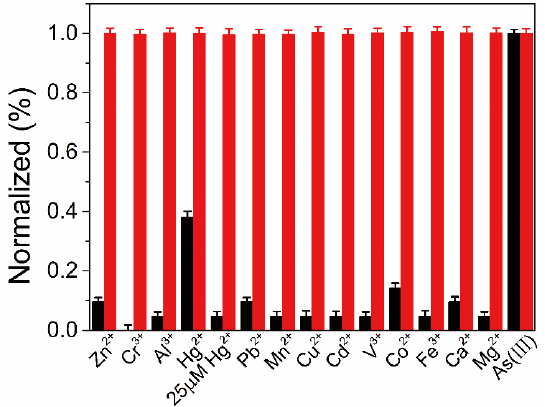
Figure 7. Selectivity test of the developed colorimetric probe for As(III) ions (6.67 µ M) over other metal ions (50 µ M, except for Hg 2+ , 25 µ M). Black bars denote the responses of individual metal ions, while red bars show the responses of As(III) (6.67 µ M) in the presence of other metal